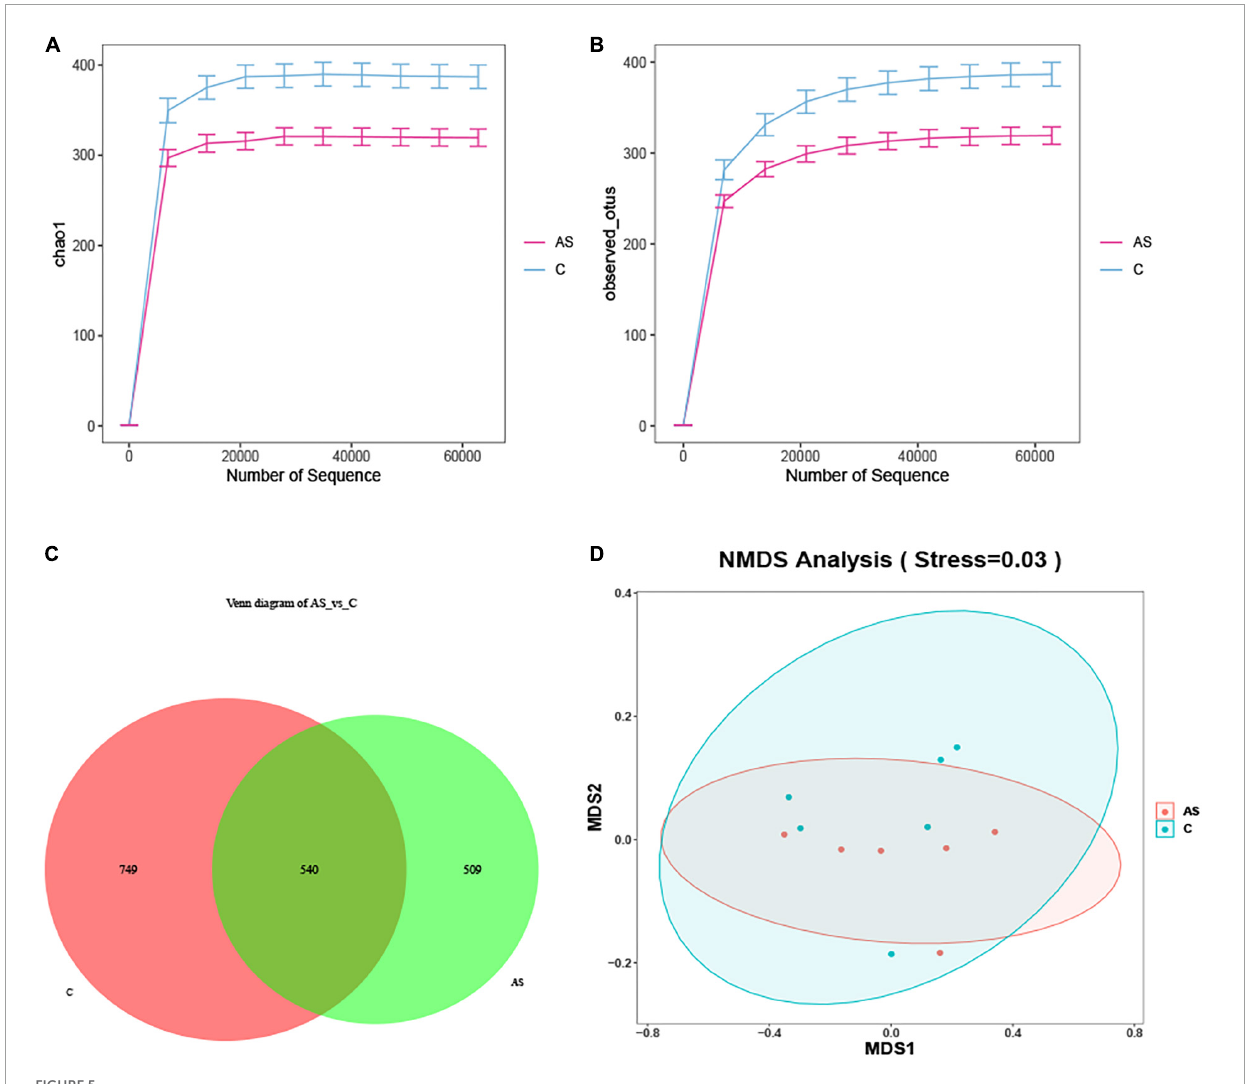
FIGURE5 Changes in the intestinal microbiota in carp after arsenic (As) exposure. (A) Chao sparsity curve. (B) Sparse curves of operational taxonomic units (OTUs). (C) Venn diagram. (D) Multidimensional scaling (NMDS) of fecal microbiota differences between the healthy fish and the As-treated